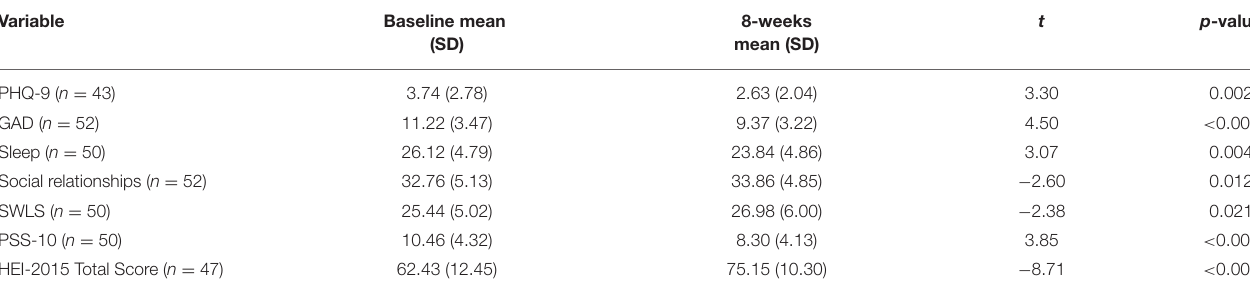
TABLE 2 | Mean values of mental wellness and diet quality scores at baseline and 8-weeks (post-intervention).